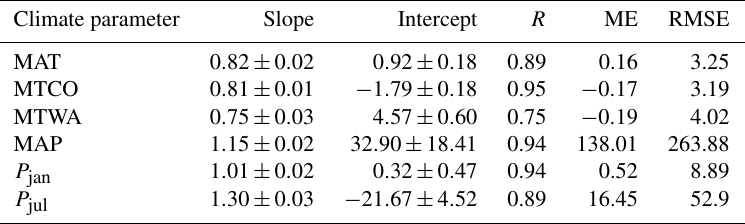
Table 6. Regression coefficients between the reconstructed climates by inverse vegetation models and observed meteorological values. Climate parameter Slope